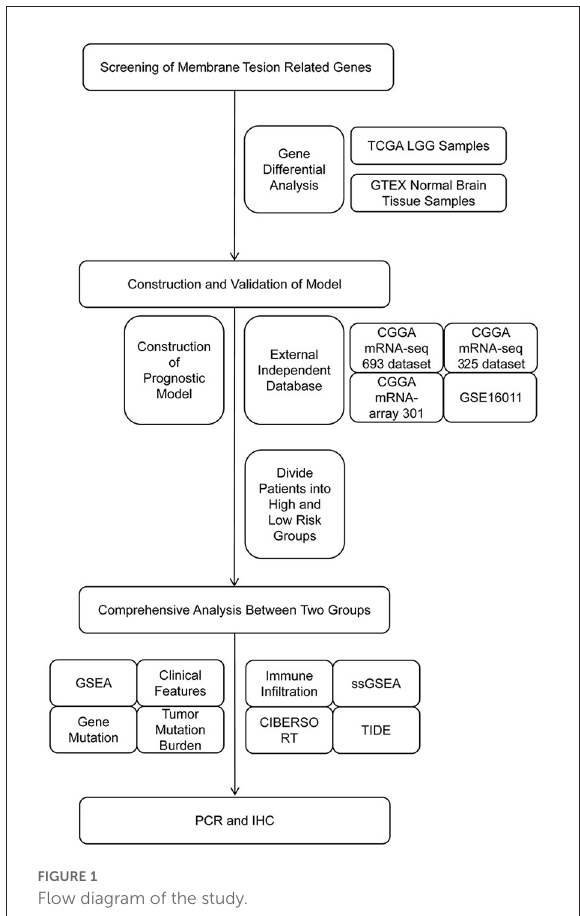
FIGURE1 Flow diagram of the